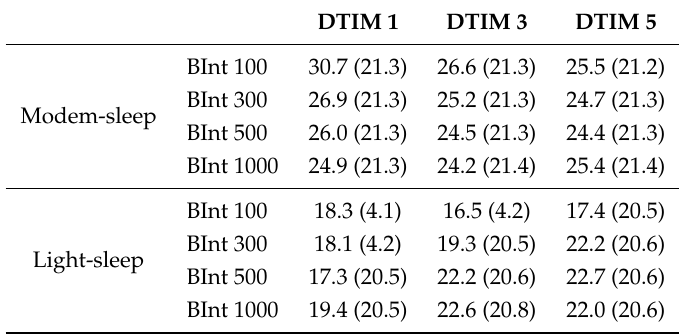
Table 3. Average (and median) current (mA) for Modem- and Light-sleep modes for different beacon intervals (ms) and DTIM